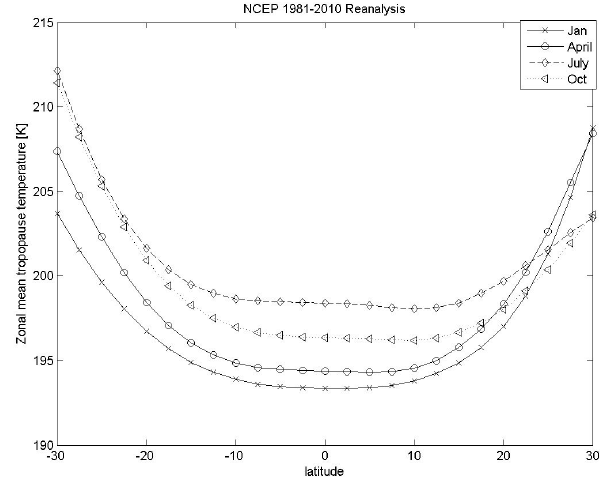
Fig. 1. Latitude dependence of the tropical tropopause cold-point Figure 1. Latitude dependence of the tropical tropopause cold-point temperature based on the NCEP 651 temperature based on the NCEP 1981–2010